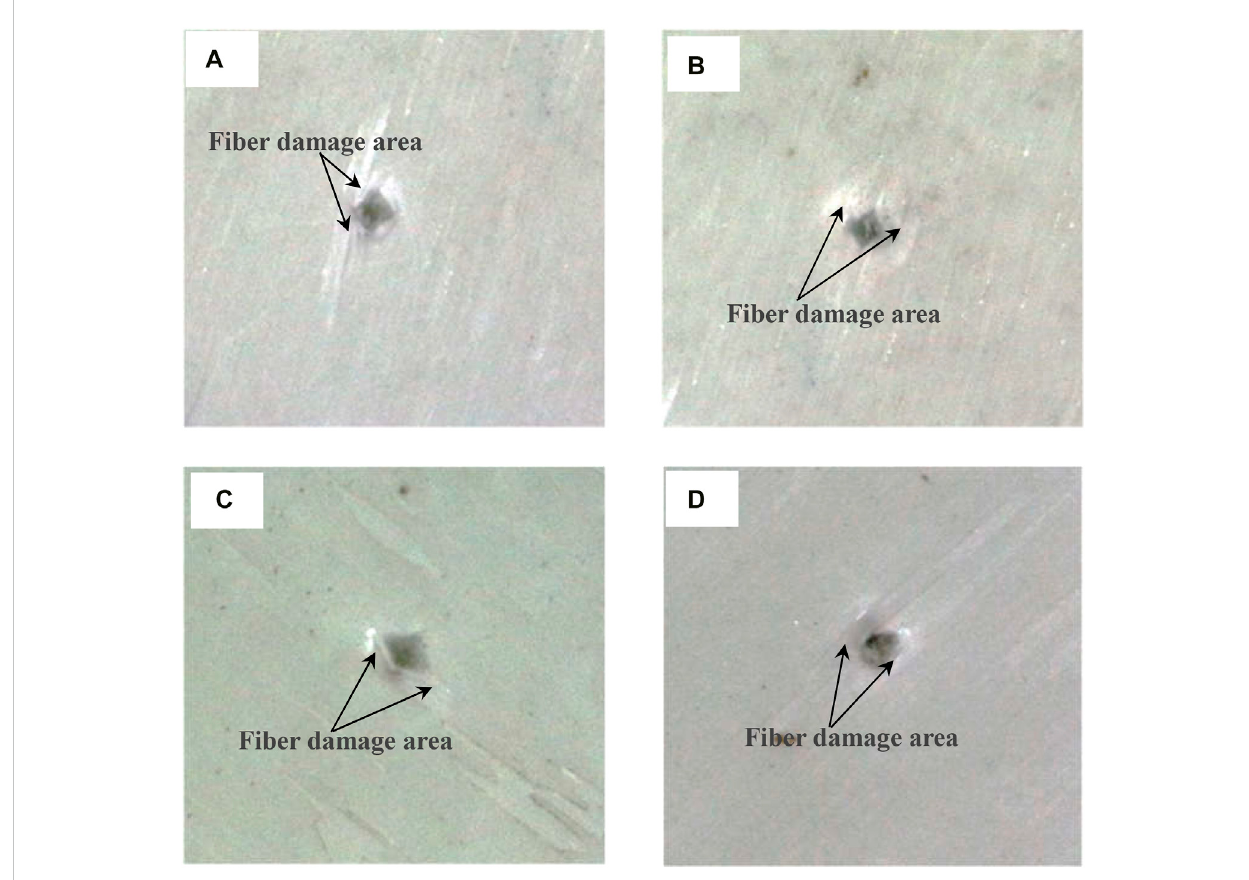
FIGURE 12 Impact damage of four biomimetic specimens. (A) Specimen15, (B) specimen30, (C) specimen60, (D)